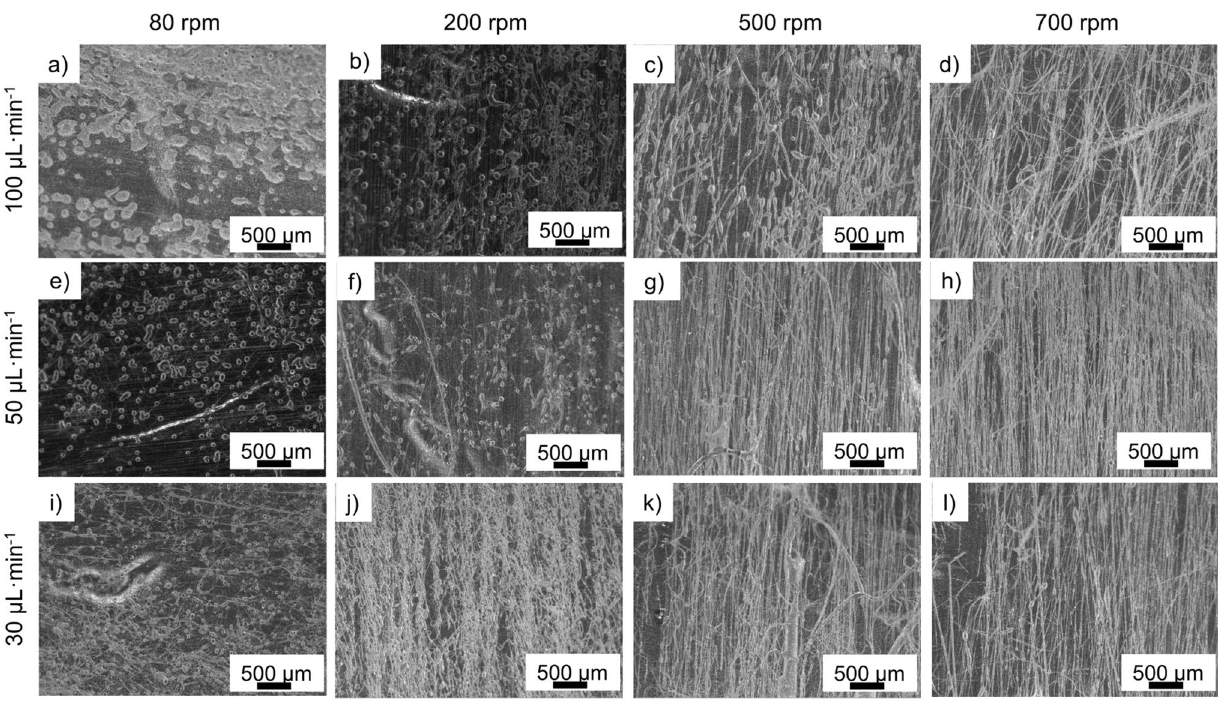
Fig. 1 Light microscope images (dark field mode, 2.5× magnification) of PVAc fibers obtained using different spinning parameters using a needle with 1.2 mm diameter at 15 kV, 5 cm distance between needle and